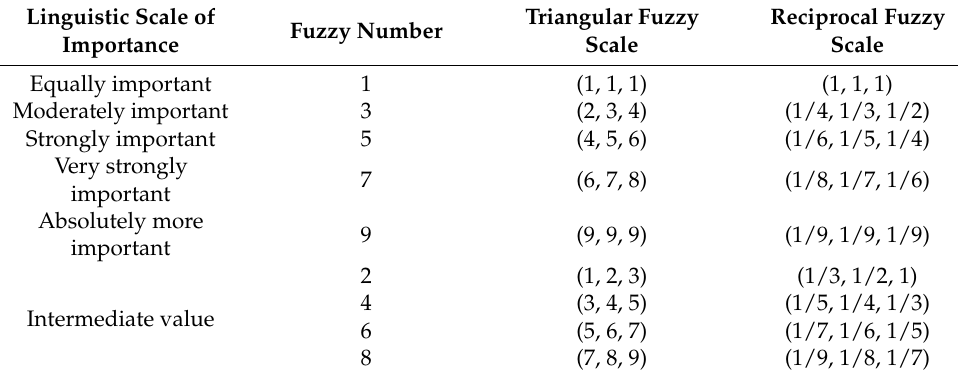
Table 2. Fuzzy comparison measures